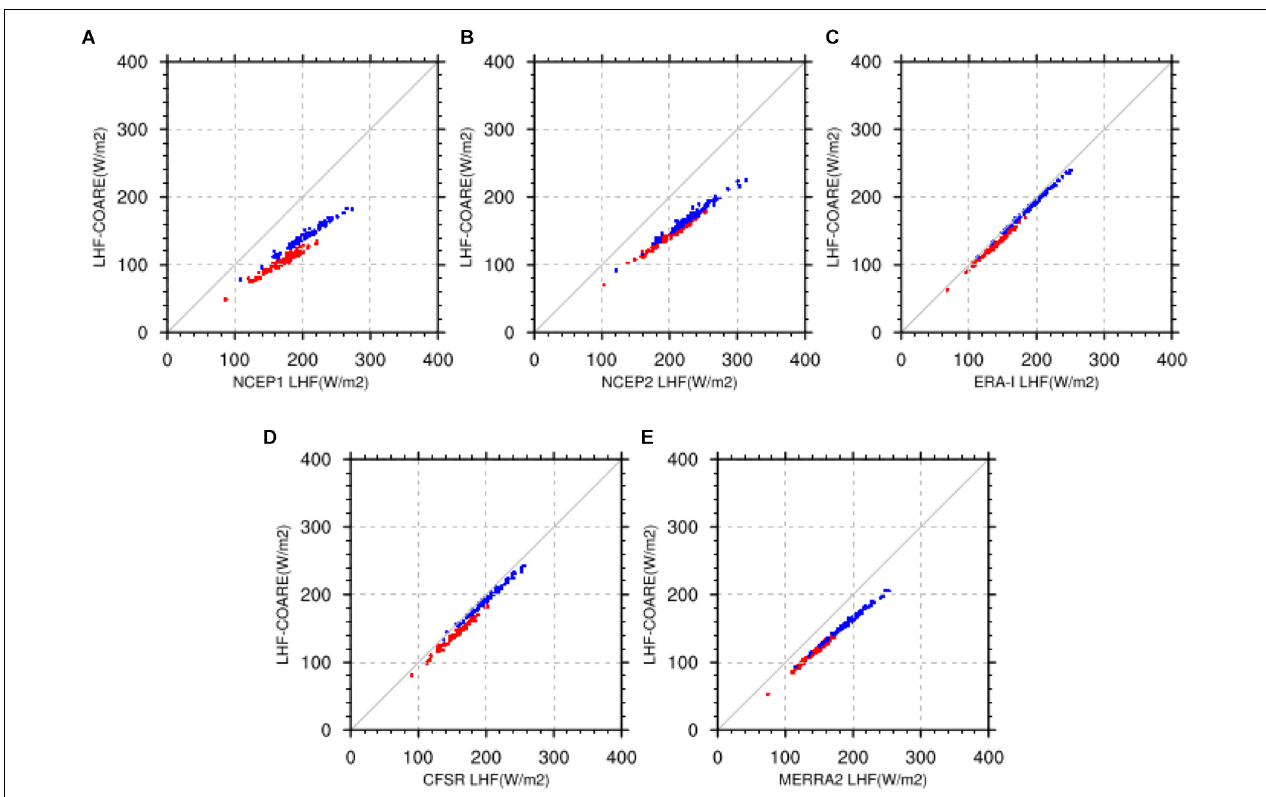
FIGURE A1 | Comparisons of monthly latent heat fluxes (LHF) from EX-alg (vertical axis) with those (horizontal axis) obtained from (A) NCEP1, (B) NCEP2, (C) ERA-Interim, (D) CFSR and (E) MERRA2. JJA (DJF) data points are shown in blue (red).